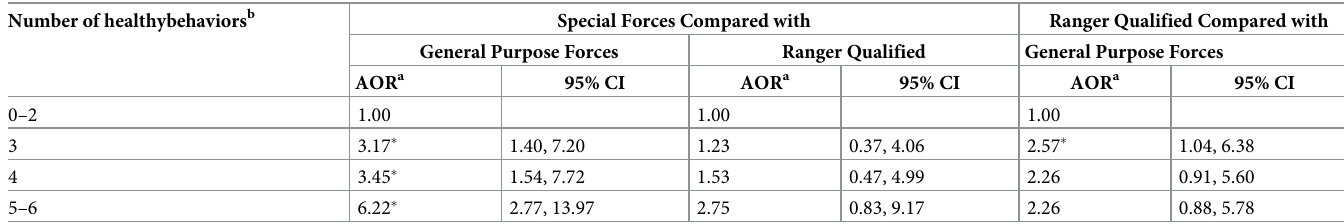
Table 4. Adjusted odds ratios of composite health score at baseline by Army specialization among soldiers, the Millennium Cohort Study. Number of healthybehaviors